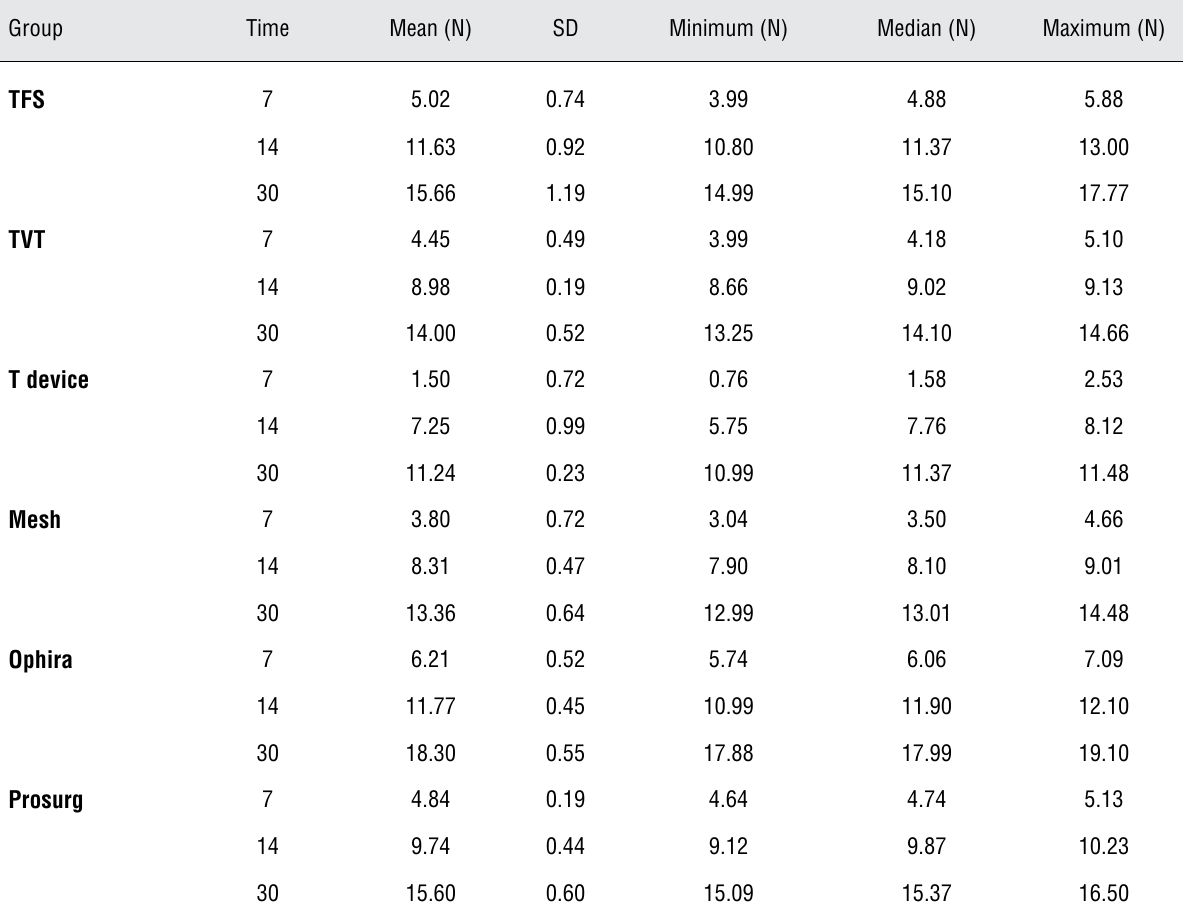
Table 1 - Loads for group and time (days). Group